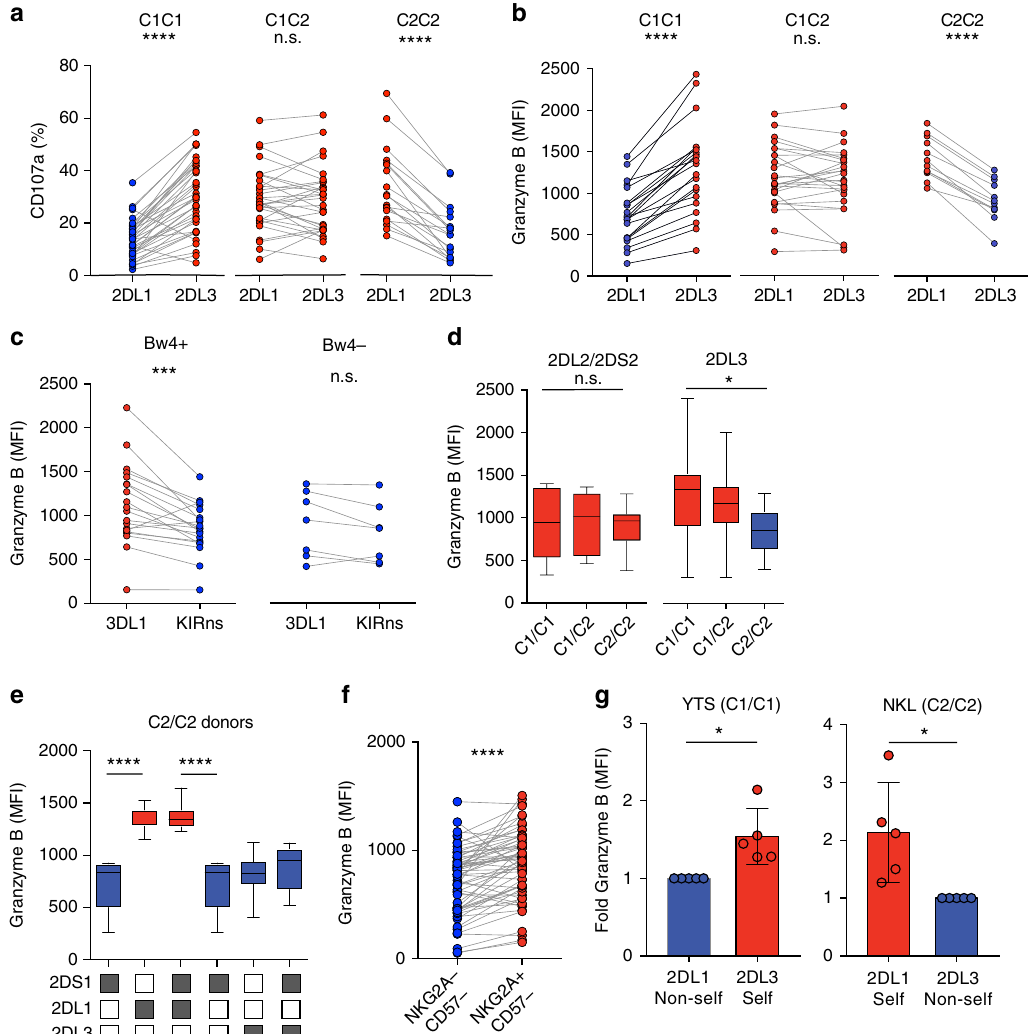
Fig. 1 NK cell education is associated with accumulation of granzyme B. a CD107a expression in response to K562 cells by the indicated KIR subset